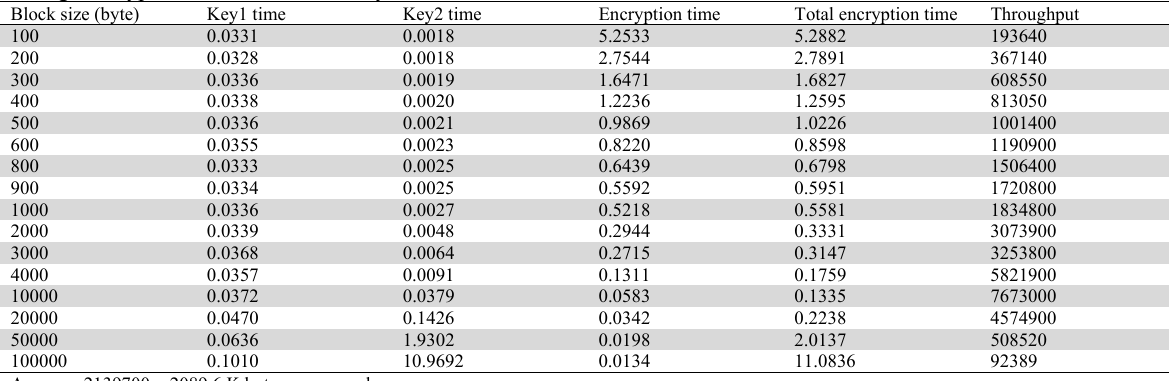
Message encryption results for 1000 Kbytes Block size (byte) Key1